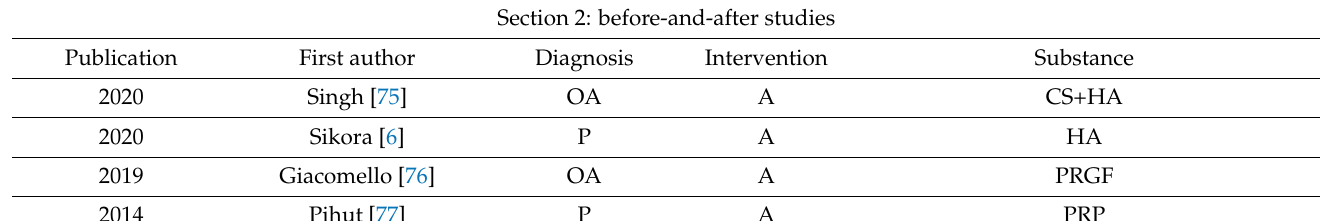
Section 2: before-and-after studies